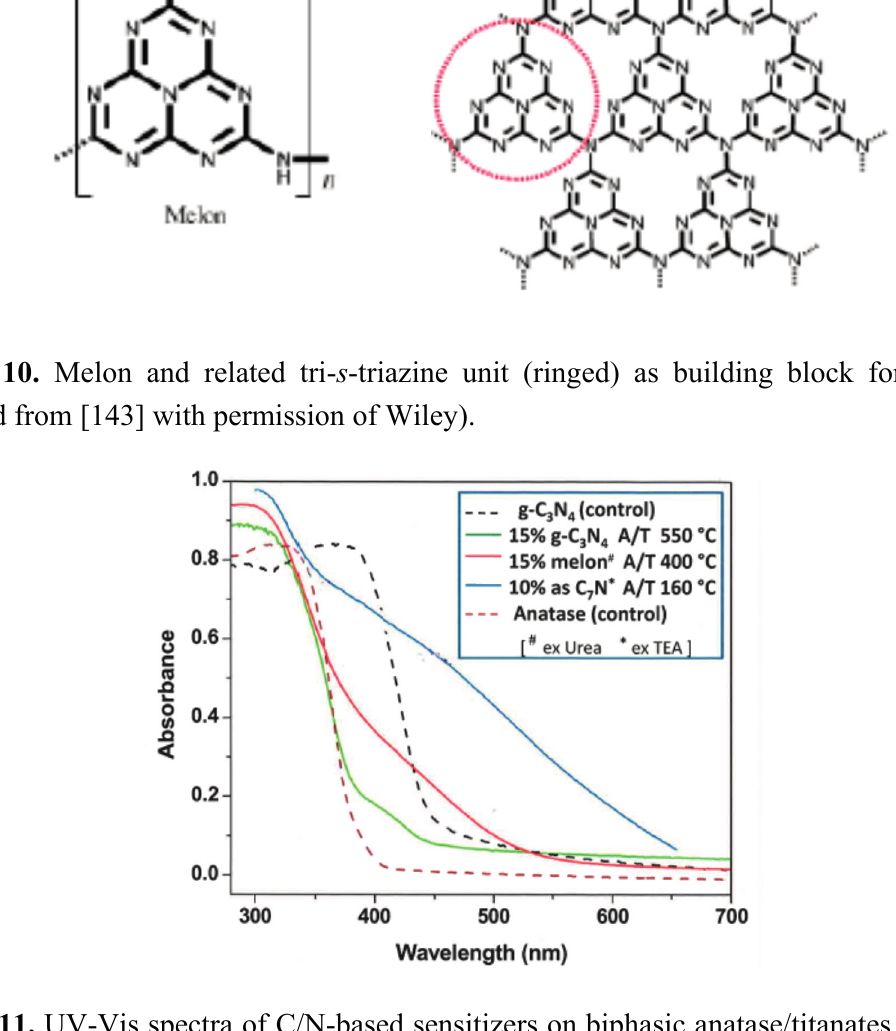
Figure 11. UV-Vis spectra of C/N-based sensitizers on biphasic anatase/titanates (adapted from [96,142] with